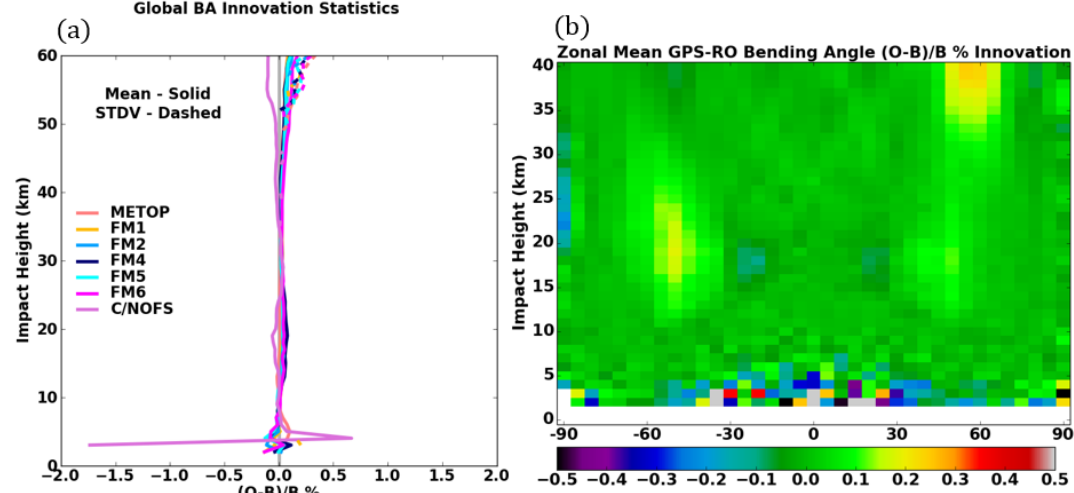
Figure 4. Difference of the bending-angle departure statistics for global (a) and zonal mean (b) between the results from data processing considering (TPD) and not considering (no_TPD) the tangent point drift (TPD minus